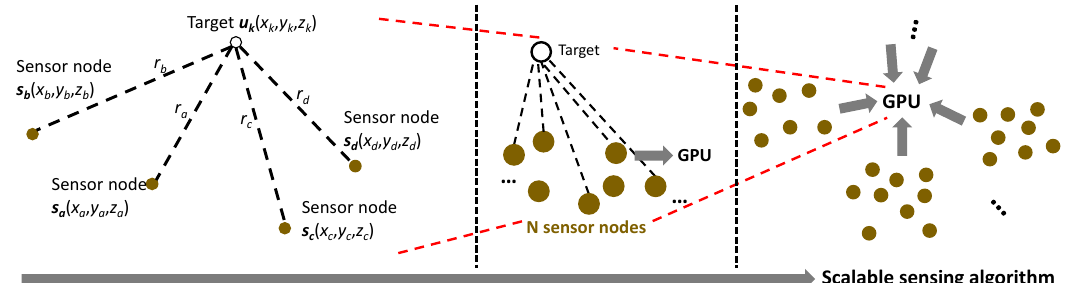
Figure 3. Scalable target position estimation using